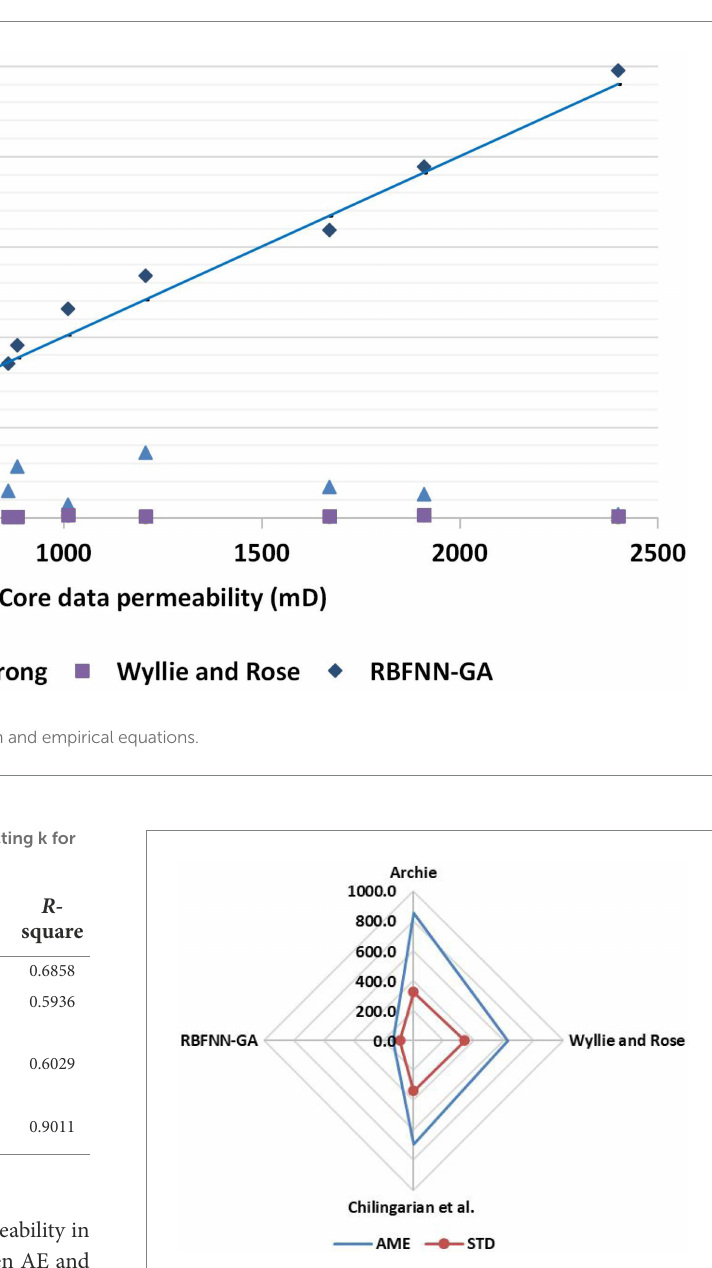
FIGURE 5 Comparison of for k prediction based on RBFNN-GA algorithm and empirical equations.